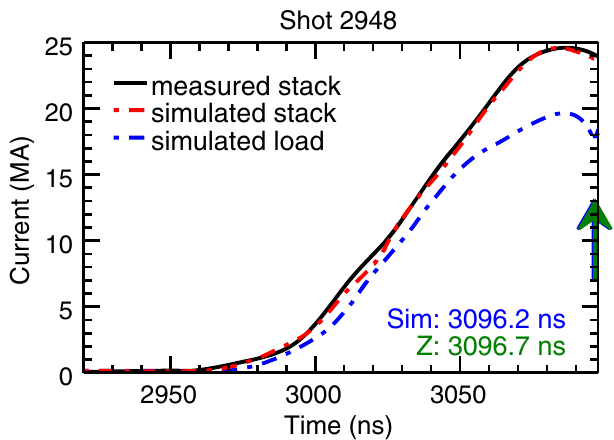
FIG. 7. Comparison of simulation and experiment results of an integrated MagLIF shot with a 7.5 mm liner and a low-inductance inner MITL